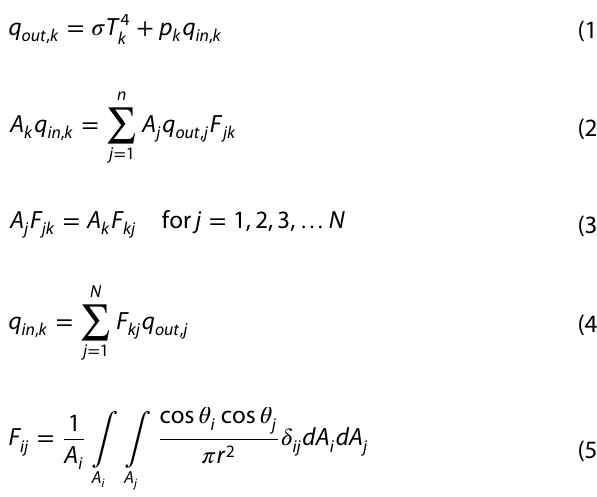
Table 1 Nanoparticle properties Property Value Chemical formula Y-Al Nano powder color White Shape Spherical Averaged diameter 20 nm Specific surface area